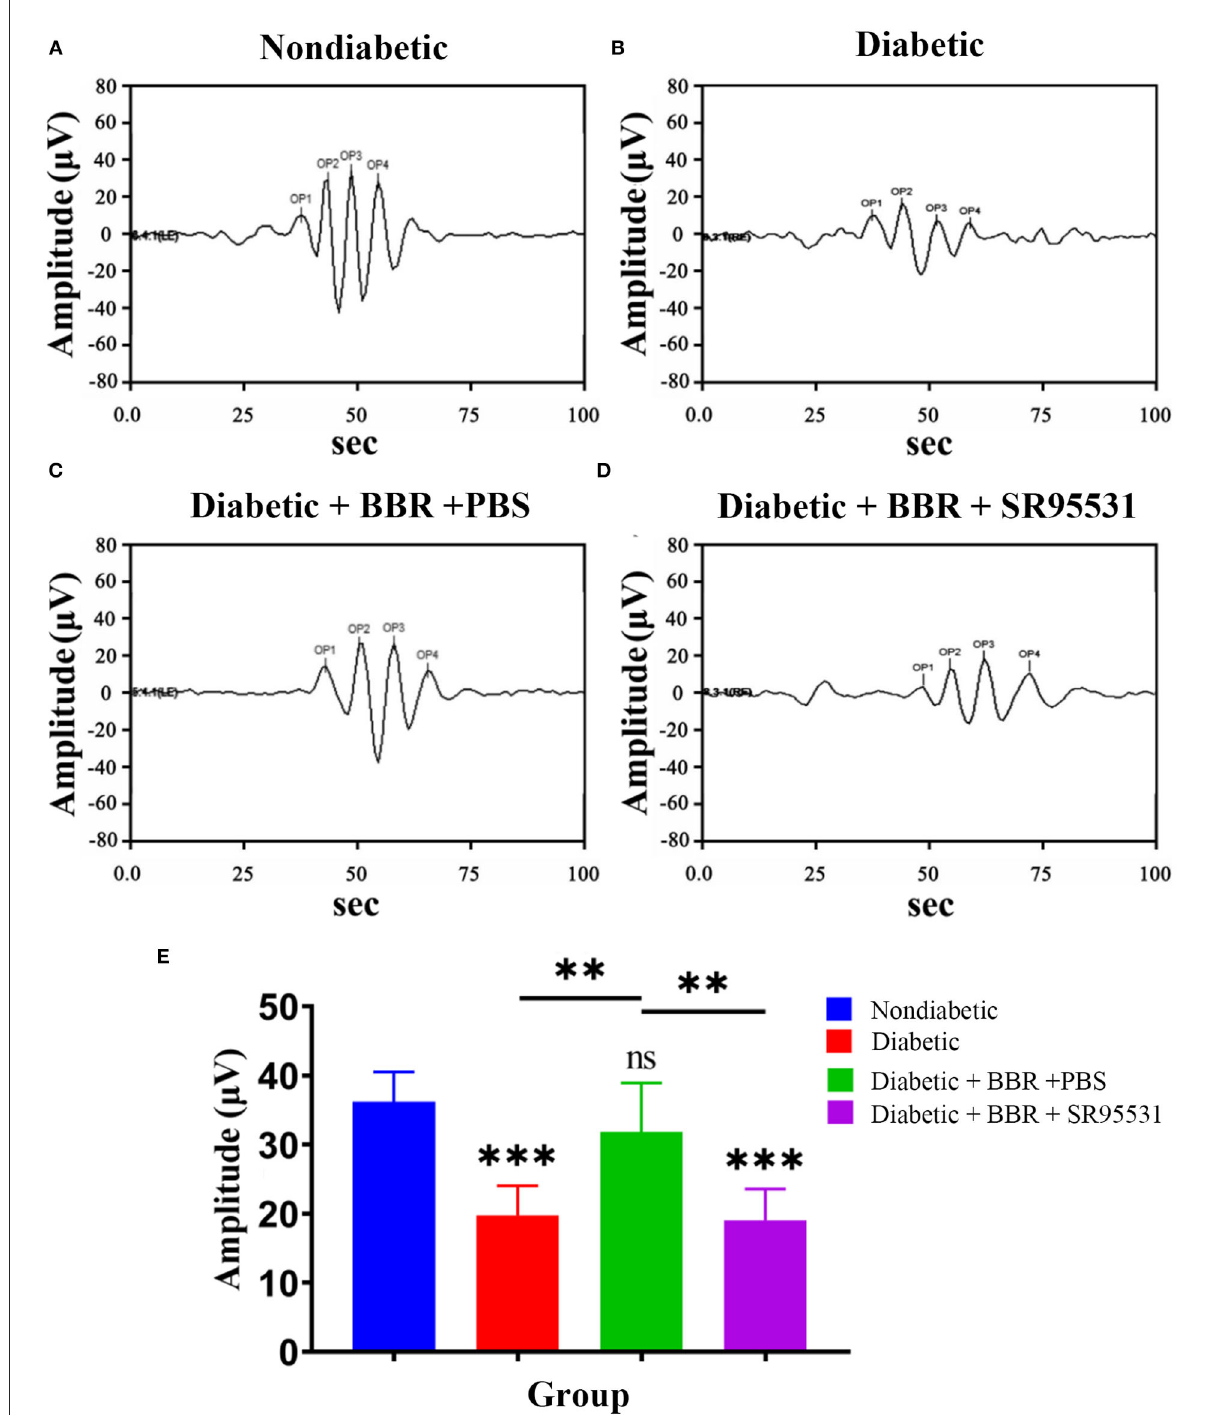
FIGURE7 Effect of BBR on retinal function, as determined by OPs. (A) Representative traces of the retinal OP waves of a control eye of the non-diabetic group at step 7 in the presence of a dark-adapted 3.0-Hz stimulus. (B) Representative waves from the eye of rats in the diabetic group at the same step and in the presence of the same stimulus as in (A) . (C) Representative waves from the eye of rats in the diabetic + BBR + PBS group at the same step and in the presence of the same stimulus as in (A) . (D) Representative waves from the eye of rats in the diabetic + BBR + SR95531 group at the same step and in the presence of the same stimulus as in (A) . (E) Quantitative analysis of OP amplitude ( n = 6; ns, no significant difference compared with the non-diabetic group; ** P < 0.01; *** P < 0.001; one-way ANOVA; OP, oscillatory potential; BBR,